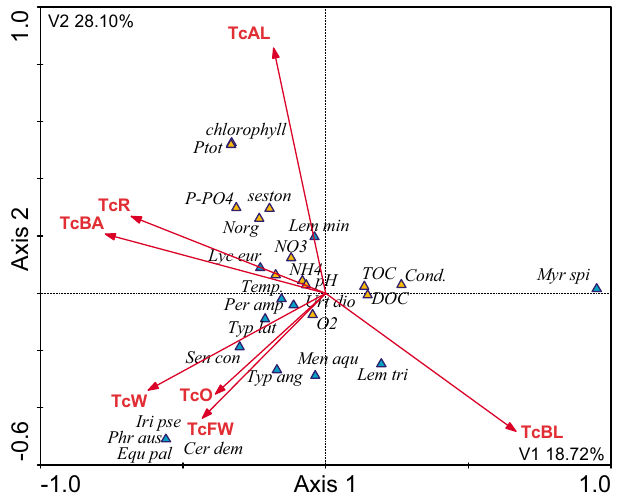
Figure 5. CCA model of dependencies between plant species, the physicochemical variables and land use types in the total catchment areas [ TcAL arable land, TcBL bushy land, TcBA built-up areas, TcR roads, TcW wasteland, TcFW flowing waters, TcO orchards. Other explanations—see Fig. 3].